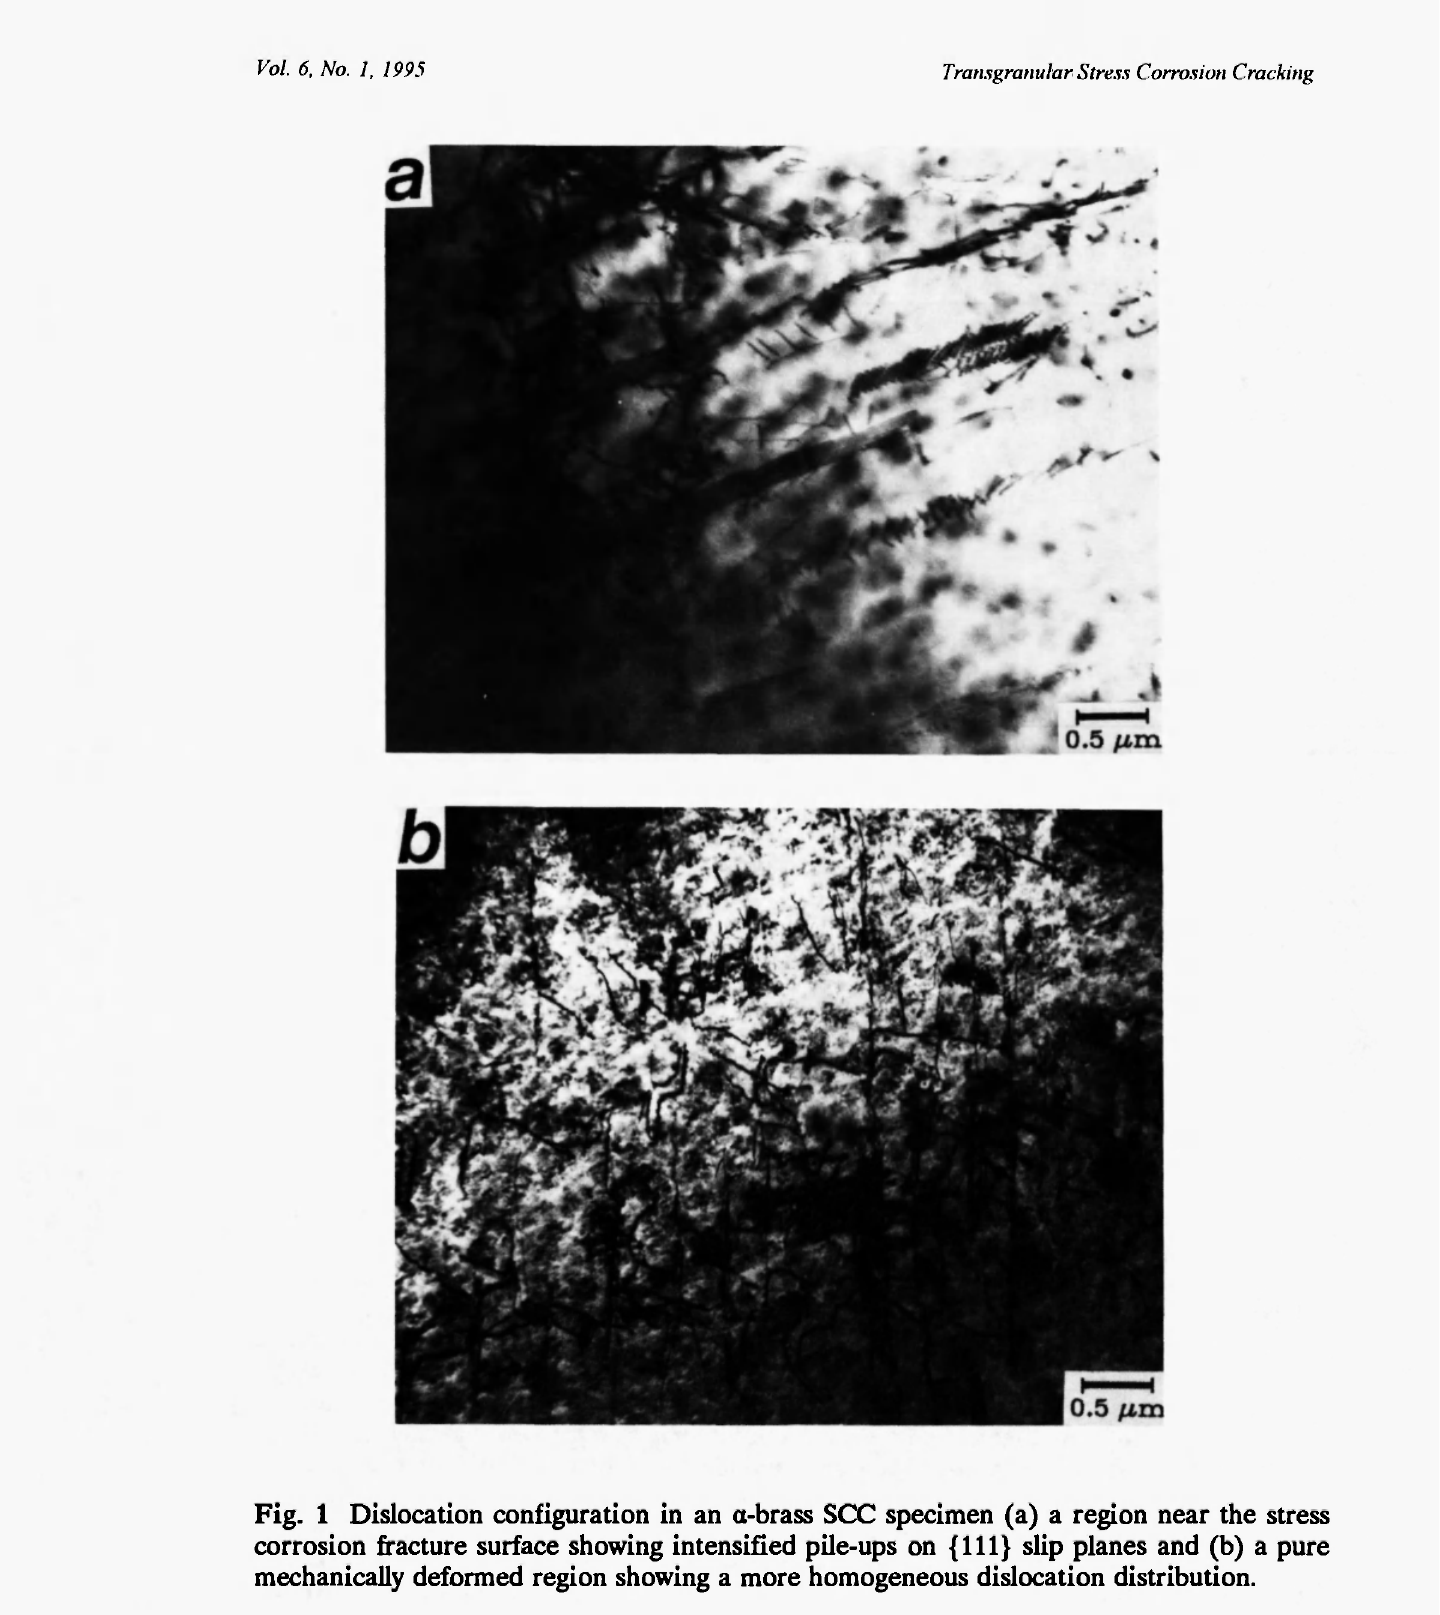
Fig. 1 Dislocation configuration in an α-brass SCC specimen (a) a region near the stress corrosion fracture surface showing intensified pile-ups on {111} slip planes and (b) a pure mechanically deformed region showing a more homogeneous dislocation